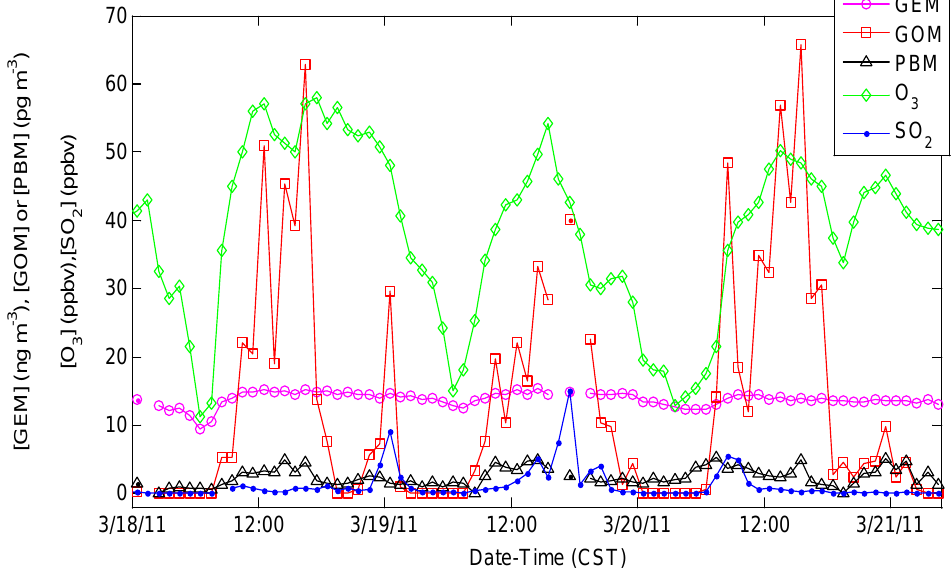
Figure 8. Time series of GEM, GOM, PBM, ozone, and SO 2 concentrations on three days in March 2011.